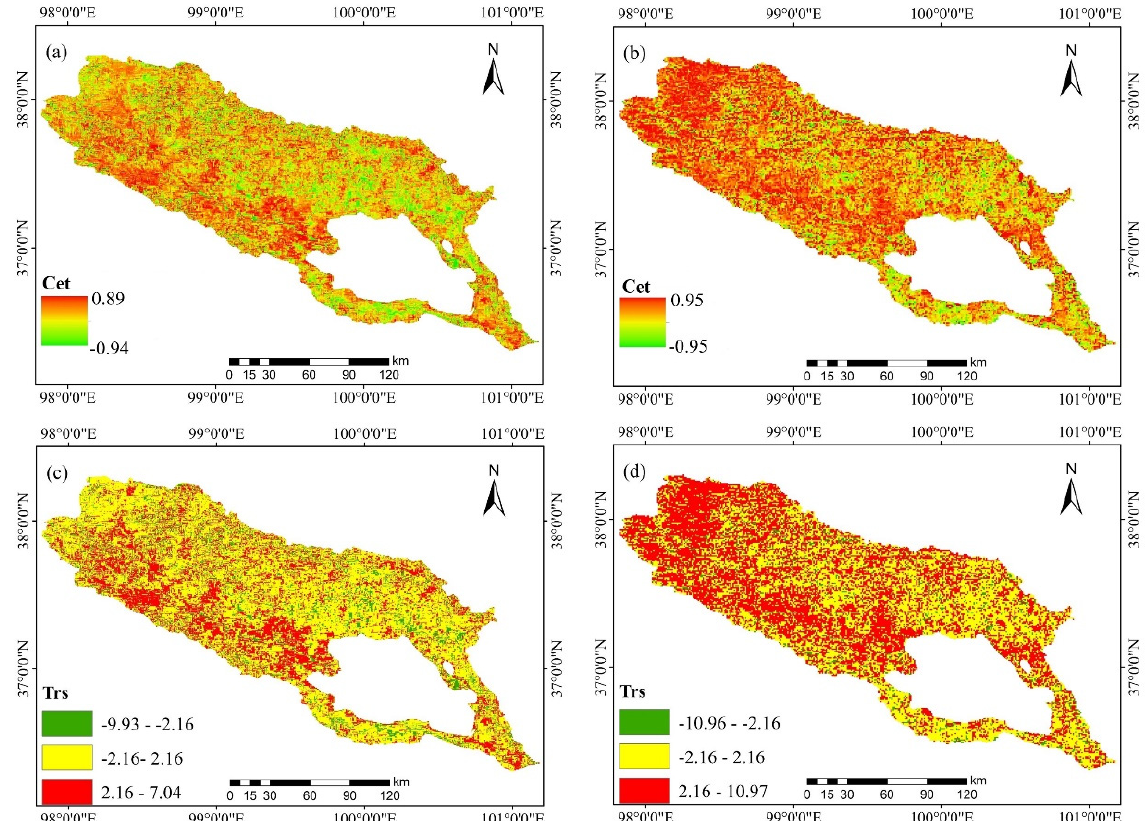
Figure 8. Spatial correlations of temperature ( a ), precipitation ( b ) with VWC and the t-test results in the Qinghai Lake Basin from 2015 to 2020. Figure ( c ) represents the t-test results of the correlation between temperature and VWC; figure ( d ) represents the t-test results of the correlation between precipitation and VWC. Cet and Trs represent correlation coefficient and t-test results, respectively.